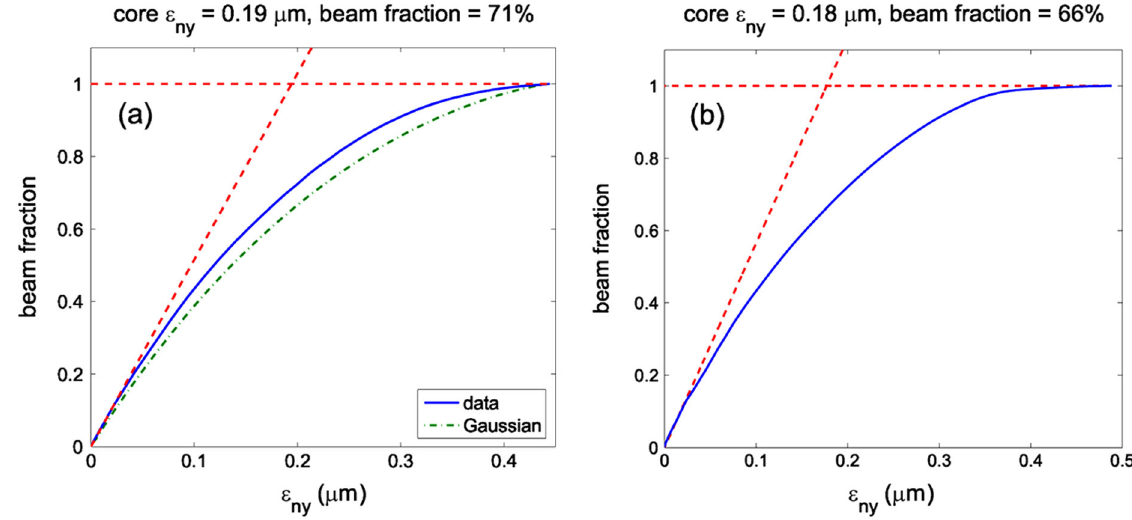
FIG. 20. (Color) Normalized rms emittance vs included beam fraction for measured (a) and calculated by GPT (b) phase space distributions for 20 pC = bunch . A corresponding Gaussian beam is also shown for comparison. The 100% normalized rms emittance is 0 : 43 (cid:2) 0 : 05 (cid:1) m for the measurement (a) and 0 : 49 (cid:1) m for GPT (b).